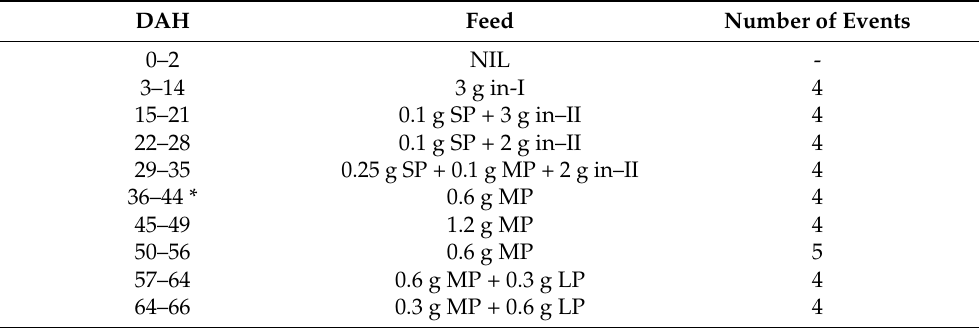
Table 1. Experimental feeding regime for giant k¯okopu larvae showing the feed provision of each feeding event and number of feeding events per day by larvae age. Instar-I Artemia (in–I), instar–II Artemia (in–II), small particle (SP), medium particle (MP), large particle (LP). * Indicates that for the period 36–44 DAH a ration of 2 g of instar–II Artemia were also administered with the fourth feed of the day only.